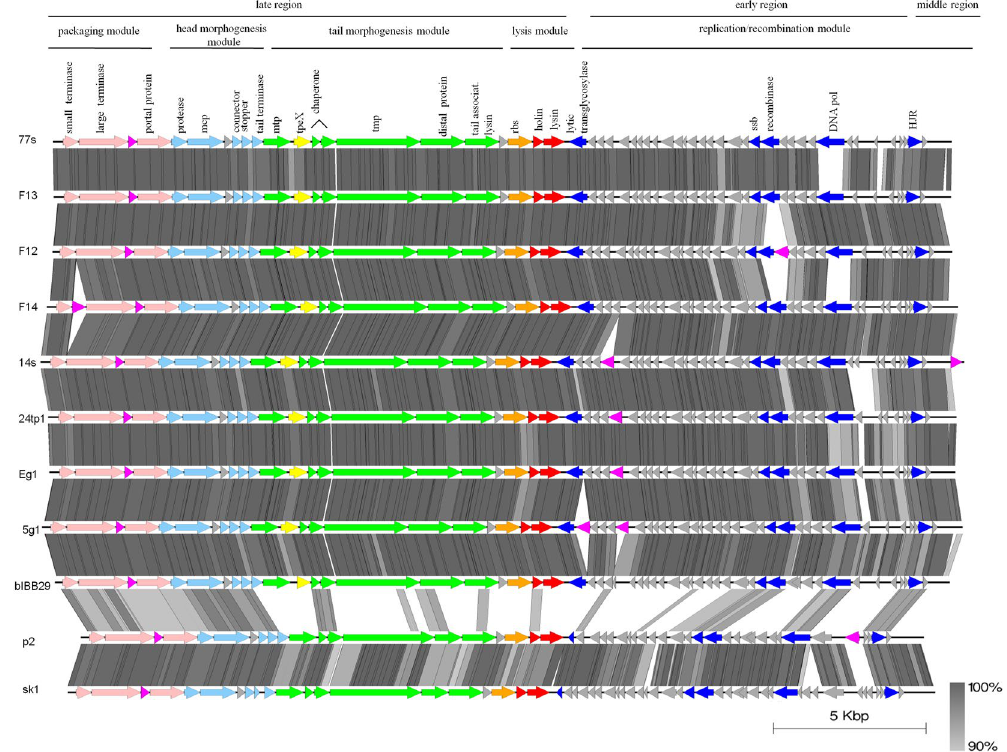
Figure 5. Schematic comparison of the Lactococcus phage genomes sequenced in this study. Arrows represent predicted genes and are coloured according to their putative function (indicated above each arrow). Genes encoding packaging proteins are in light pink; head morphogenesis, light blue; tail morphogenesis, green; TpeX-encoding genes, yellow, RBP-encoding genes, orange; host cell lysis, red; orfs of unknown function, grey; HNHE-encoding genes, pink; annotated functions of the early and middle genome region are in navy blue. The genomes of phages bIBB29, p2 and sk1 are shown as references. The grey shading between genomes represents tblastx matches according to the BLAST identity scale